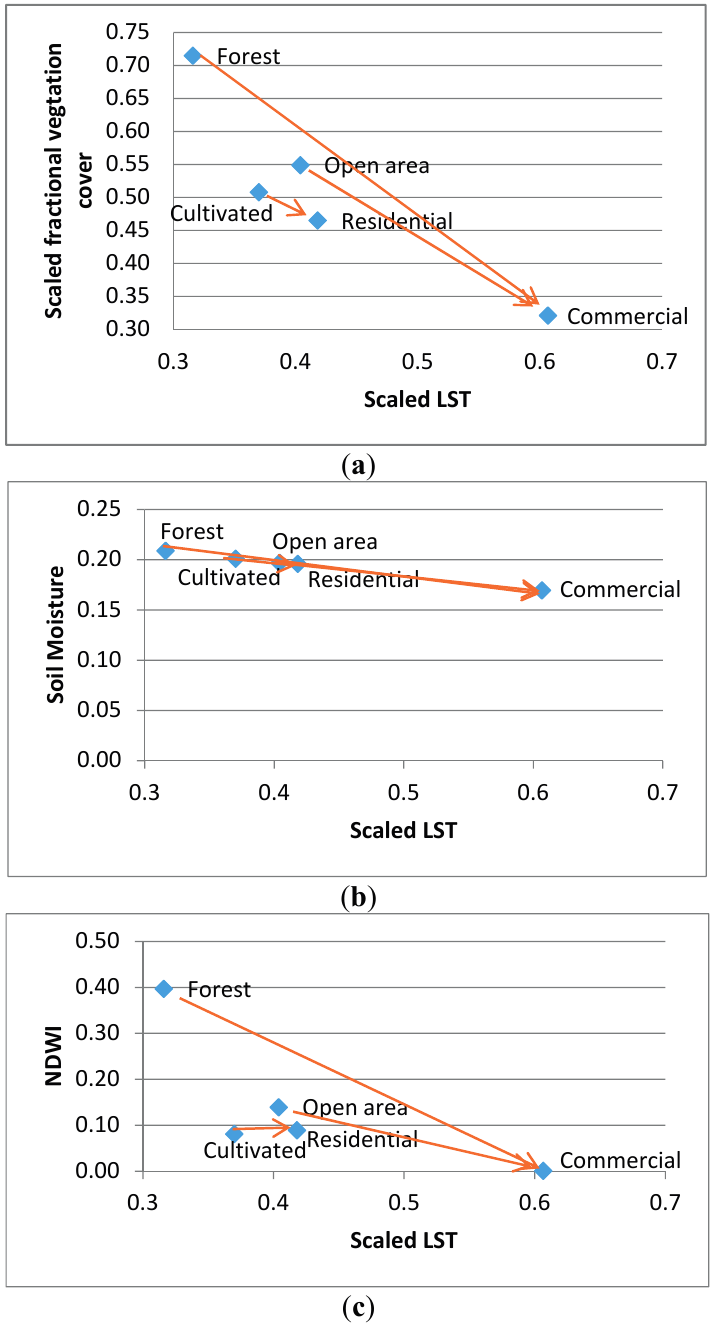
Figure 7. ( a ) Pixel trajectories in the TVX space, ( b ) Temperature-soil moisture space, and ( c ) Temperature-NDWI space from 17 June 2001 to 1 July 2006. Cultivated to residential was represented by Area 1, Forest to commercial was represented by Area 1, and open area to commercial was represented by Area